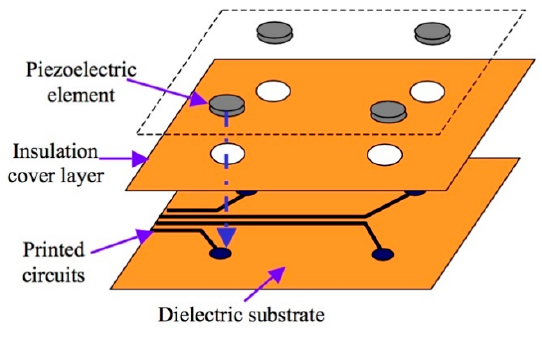
Figure 2. Basic configuration of sensor layer [17].